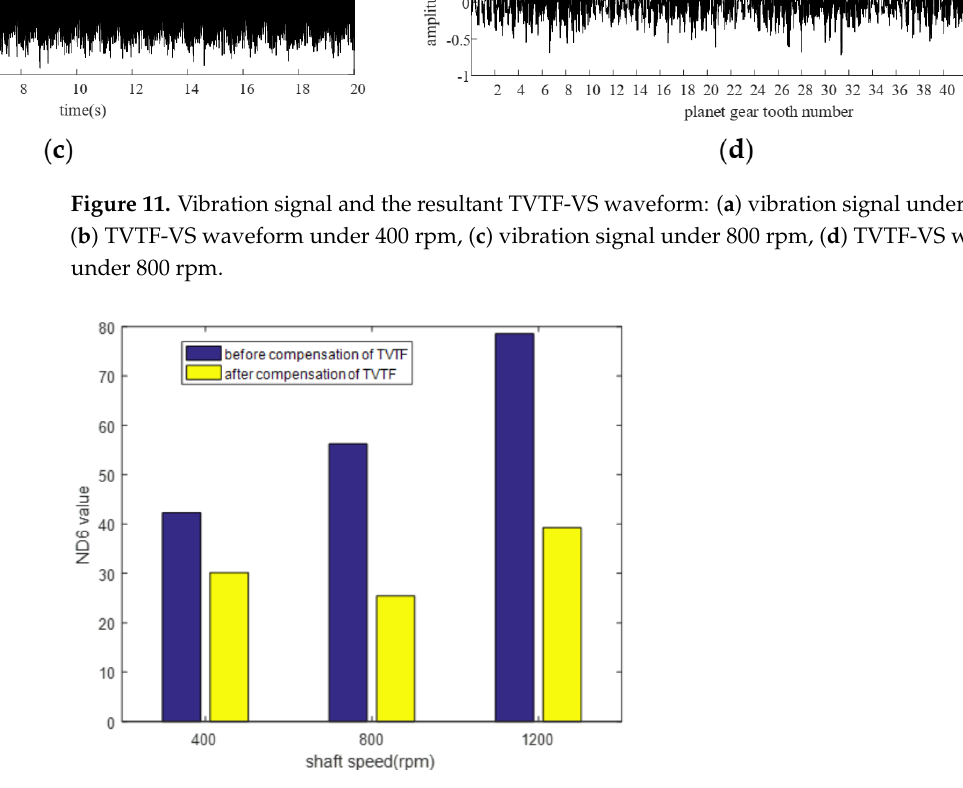
Figure 12. ND 6 value before and after compensation of TVTF with different